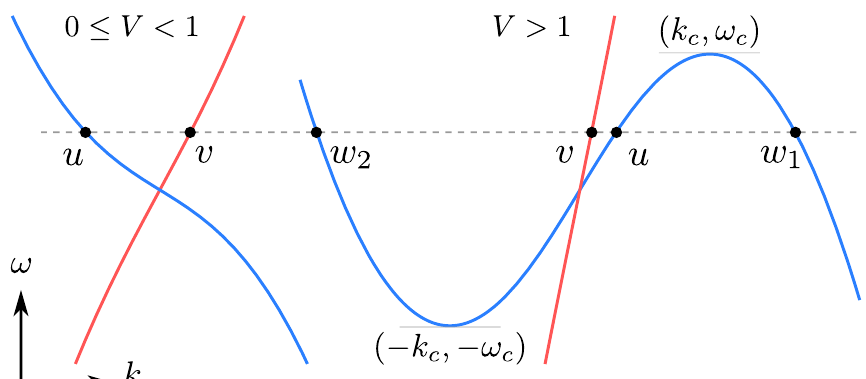
Figure 2: Dispersion relation for k ⊥ = ( ± k ,0 ) in the undertilted (0 ≤ V < 1) and 0 overtilted case ( V > 1) where the copropagating and counterpropagating branch correspond to the red and blue solid lines,